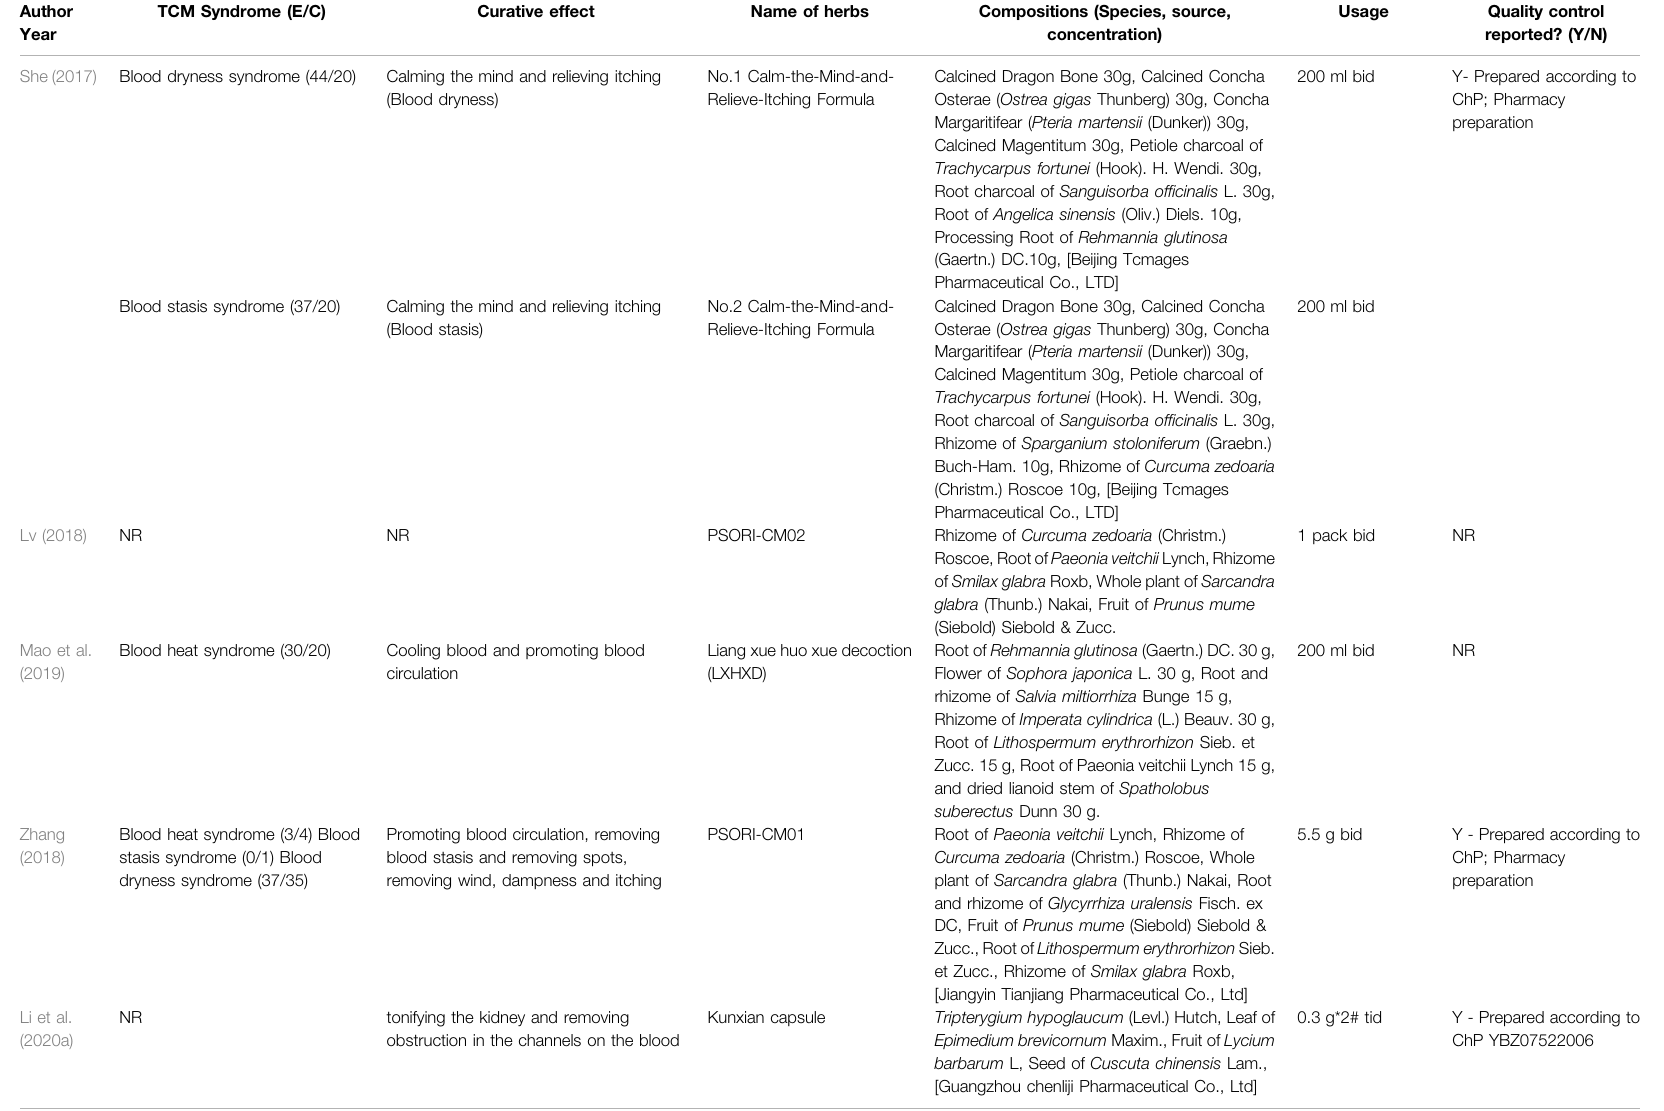
TABLE 1 | ( Continued ) Summary of the characteristics of the included